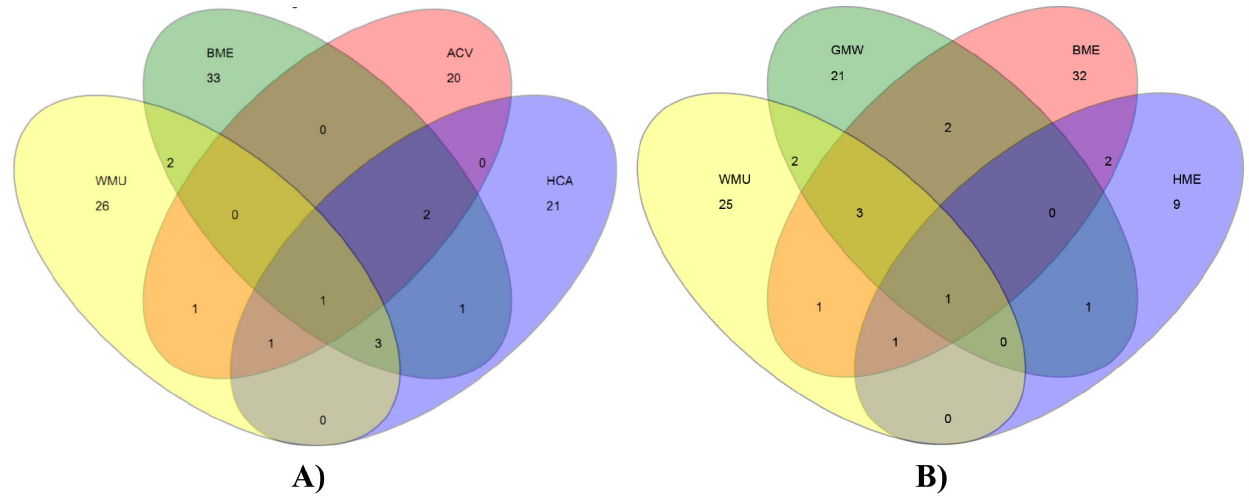
Figure 6. Overlap in fungal community composition across bat WNS-afflicted environmental samples. Venn diagram demonstrates the degree of overlap of OTU similarity among niches. OTUs were defined using 97% genetic similarity cut-off. A) Venn diagram displays the overlapping OTUs among ACV, BME, WMU, and HCA; B) Venn diagram displays the overlapping OTUs among GMW, BME, WMU, and HME. ACV, Aeolus Cave, Bennington County, VT; BME, Barton Mine, Essex County, NY; GMW, Graphite Mine, Warren County, NY; HME, Hitchcock Mine, Essex County,